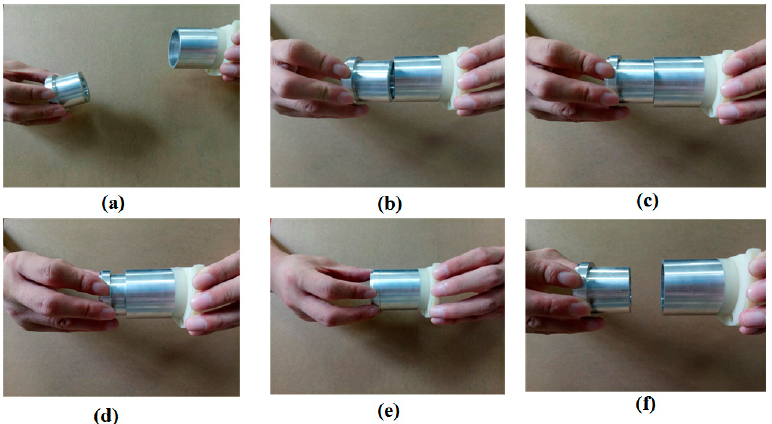
Figure 3. Human behaviors toward the peg-in-hole assembly based on contact information (( a ): the peg approaches to the hole; ( b ) and ( c ): the peg and the hole are adjusting the orientation and position outside, respectively; ( d ) and ( e ): the peg and the hole are adjusting the orientation and position inside, respectively; ( f ): the peg removes from the hole).